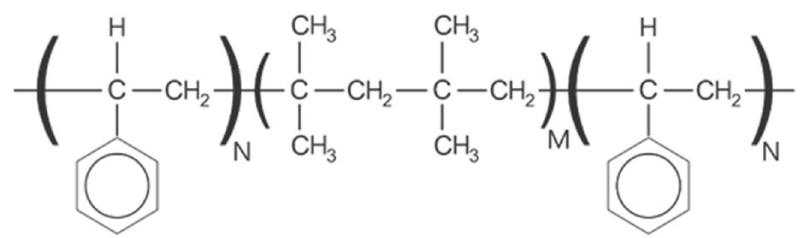
Figure 1. Simplified chemical structure of SIBS. M = number of isobutylene units; N = number of styrene units; SIBS = poly(styrene-block-isobutylene-block-styrene).